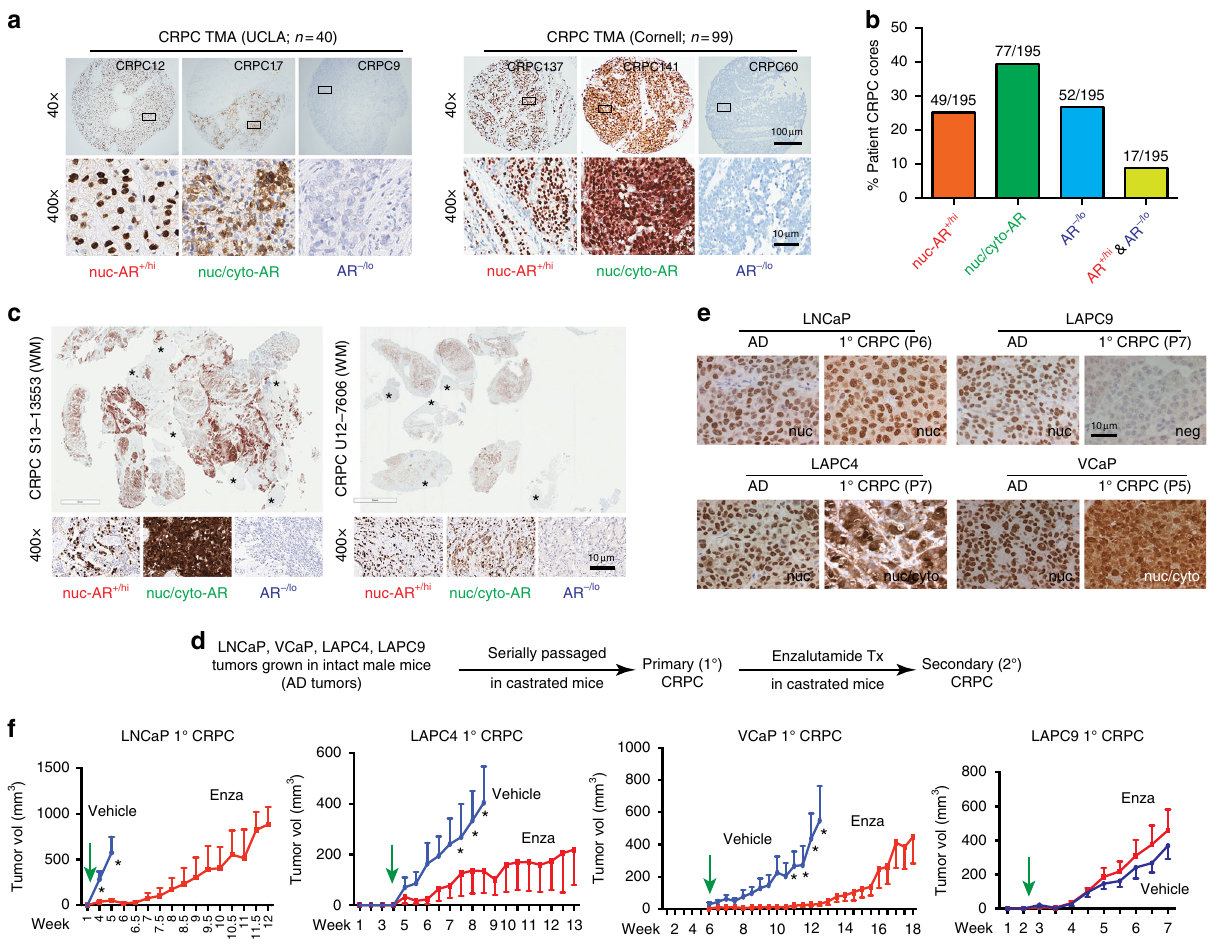
Fig. 1 Linking AR heterogeneity in CRPC to distinct Enza response. a , b AR IHC images ( a ) and quanti fi cation of AR expression patterns ( b ) in 195 CRPC cores from three TMAs. Original magni fi cations and scale bars are indicated. c AR IHC in WM sections from two CRPC patients (i.e.# S13-13553 and U12- 7606). Shown below are 3 AR patterns (original magni fi cations and scale bar indicated). *AR − /lo areas. d Experimental scheme to generate primary (1°) and secondary (2°) xenograft CRPC. Tx, treatment. e AR IHC in 4 AD/1° CRPC (P, passage number) xenografts showing 3 AR expression patterns (nuc- AR + /hi , nuc/cyto-AR, or AR − /lo ) (all 400×; scale bar indicated in one panel). Note that although LAPC4 CRPC is classi fi ed as nuc/cyto-AR, the main AR expression pattern is cytoplasmic. f Therapeutic responses of 4 xenograft CRPCs to Enza. Presented are tumor volumes (mm 3 ; note that only half of the error bars were shown to avoid crowdedness in the line graphs) as a function of treatment time. Green arrows indicate the starting point of Enza treatment. * P < 0.01 (Student ’ s t -test; n = 10 for the vehicle and Enza groups, respectively, for each tumor